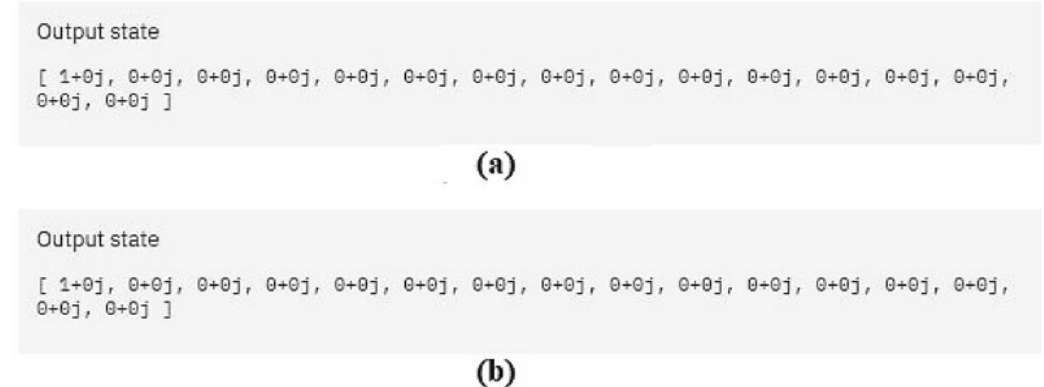
Figure 16. ( a ) The simulation result of the output of the quantum circuits test for the KNN algorithm before and after optimization in ( a ) and ( b ), respectively. The results are